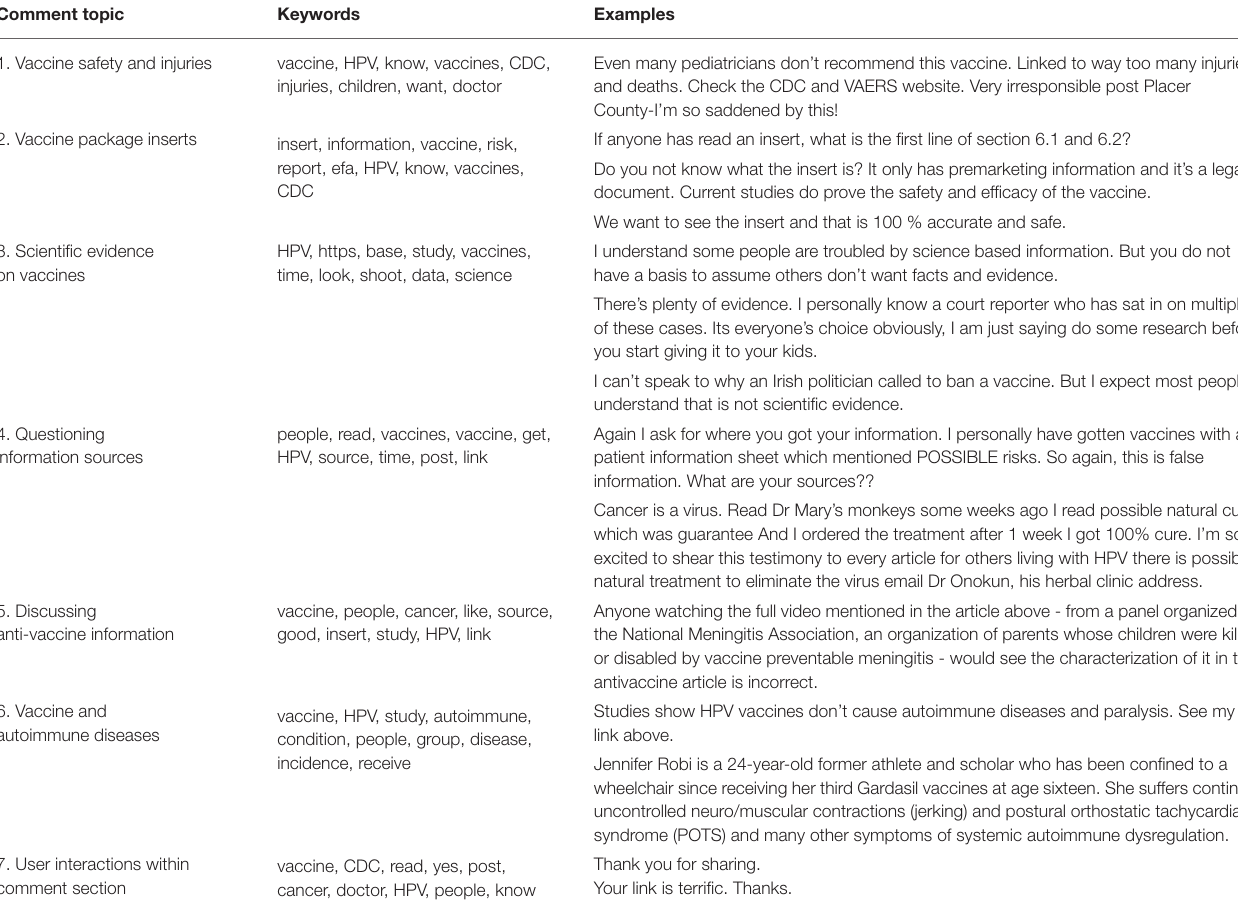
TABLE 5 | Thematic topics, keywords, and example Facebook comments about the HPV